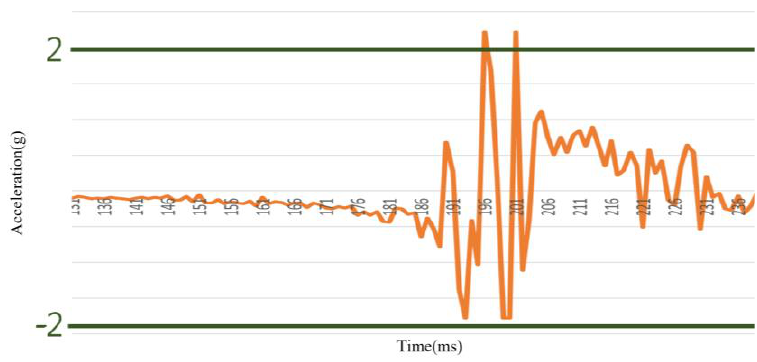
Figure 15. Acceleration for fall